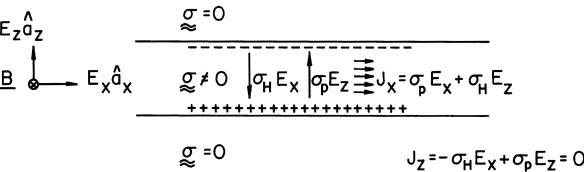
Fig. 2. The slab geometry model of the equatorial electrojet (from Kelley,